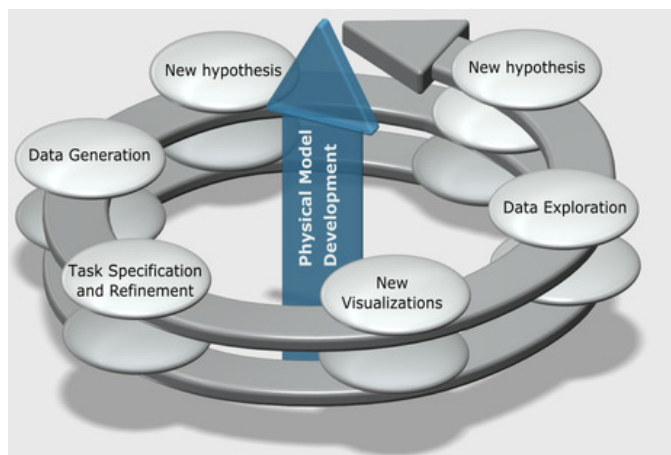
Figure 1. The visualization system has become an essential part of the scientific process in the applications and the specific tasks toward the system have been developing continuously. New hypotheses that are developed during the visual exploration trigger new tasks and new visualization methods as specific efficiency measures used for statistical plots and line